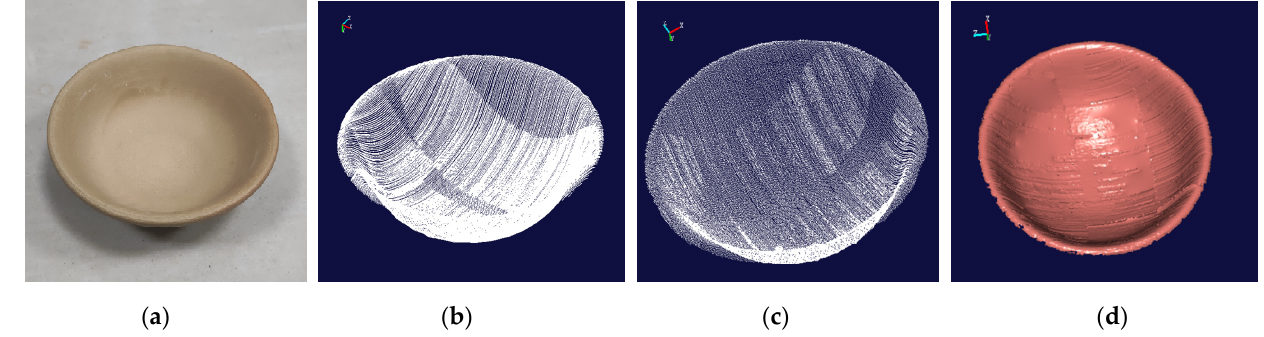
Figure 21. The related images of the ceramic bowl. ( a ) the original image. ( b ) the original point cloud image. ( c ) the point cloud image after down-sampling. ( d ) the rendering image. image. ( c ) the point cloud image after down-sampling. ( d ) the rendering